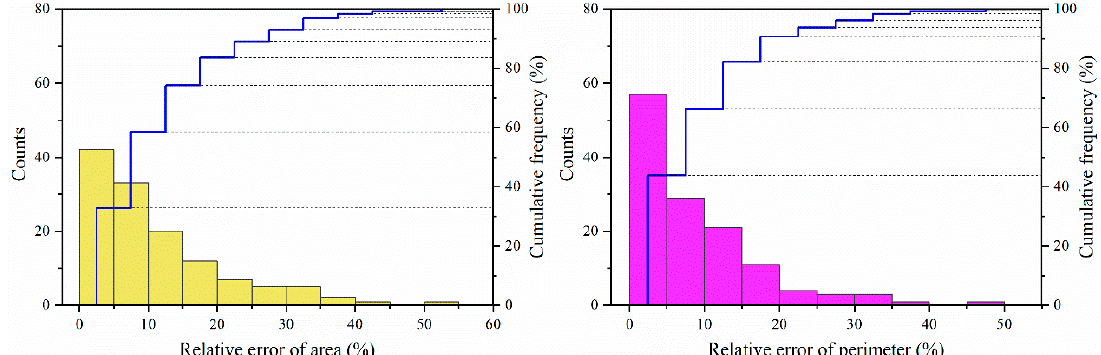
Figure 3. Frequency distribution of the relative errors of gully area and gully perimeter.